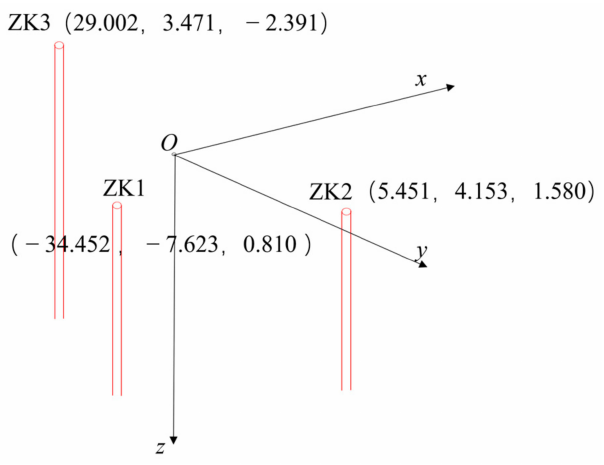
Figure 14. Relative position diagram of the three boreholes.